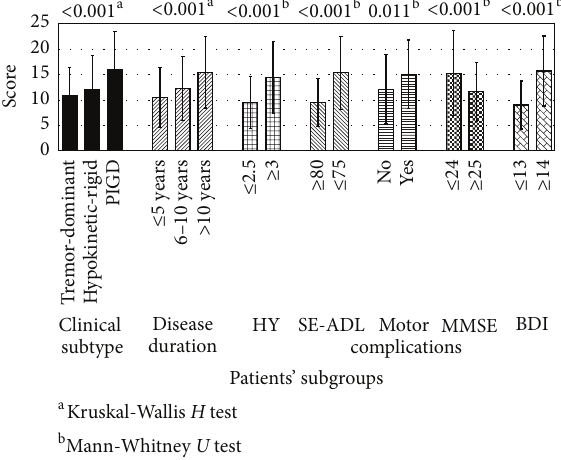
scores in terms of gender, age, and age at onset of the disease. As regards motor complications in their variations, signifi- cantly higher MDS-UPDRS Part I scores were reported in patients with motor fluctuations, compared to nonfluctuating patients ( 𝑝 < 0.026 ), but no difference was seen comparing patients with and without dyskinesias ( 𝑝 < 0.046 ), and no difference was seen comparing patients with and without off- period dystonia ( 𝑝 < 0.065